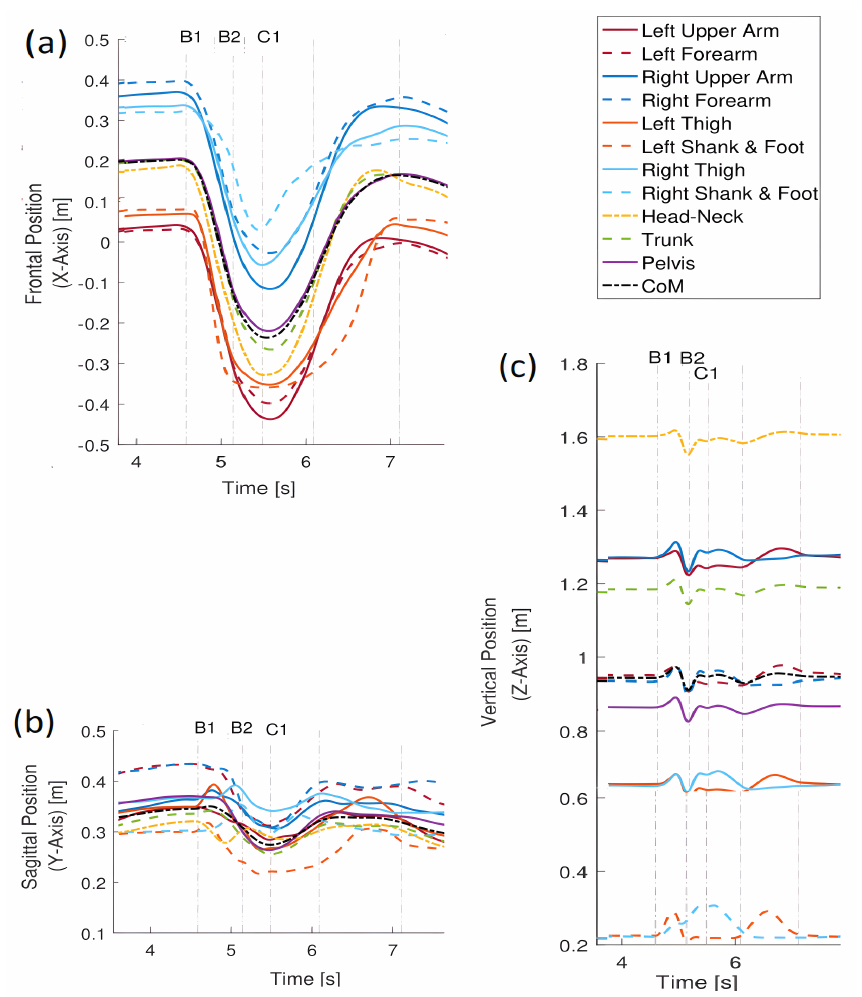
Figure 12. Displacement trajectories during push recovery with tied arms. ( a ) trajectories along the X-axis; ( b ) trajectories along the Y-axis; ( c ) trajectories along the